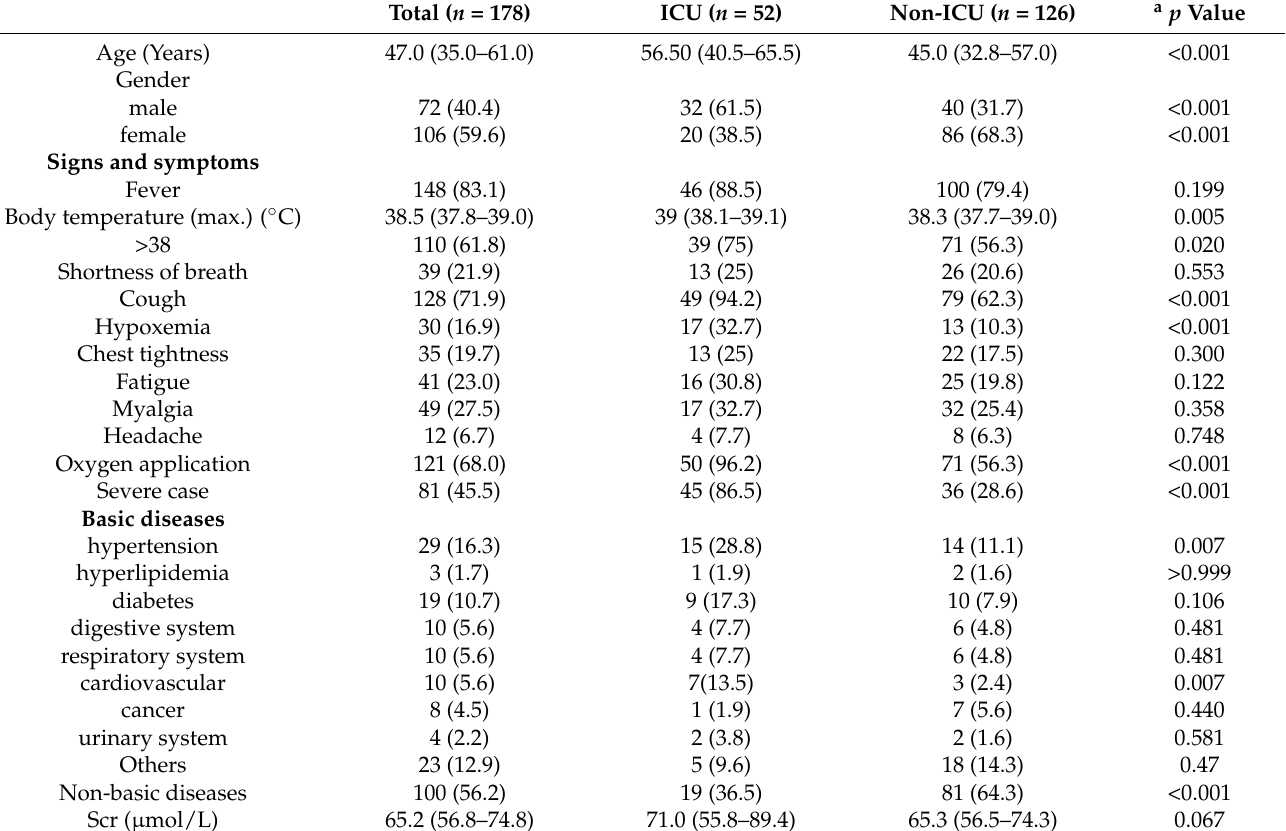
Table 1. Basic information and blood indicators related to kidney